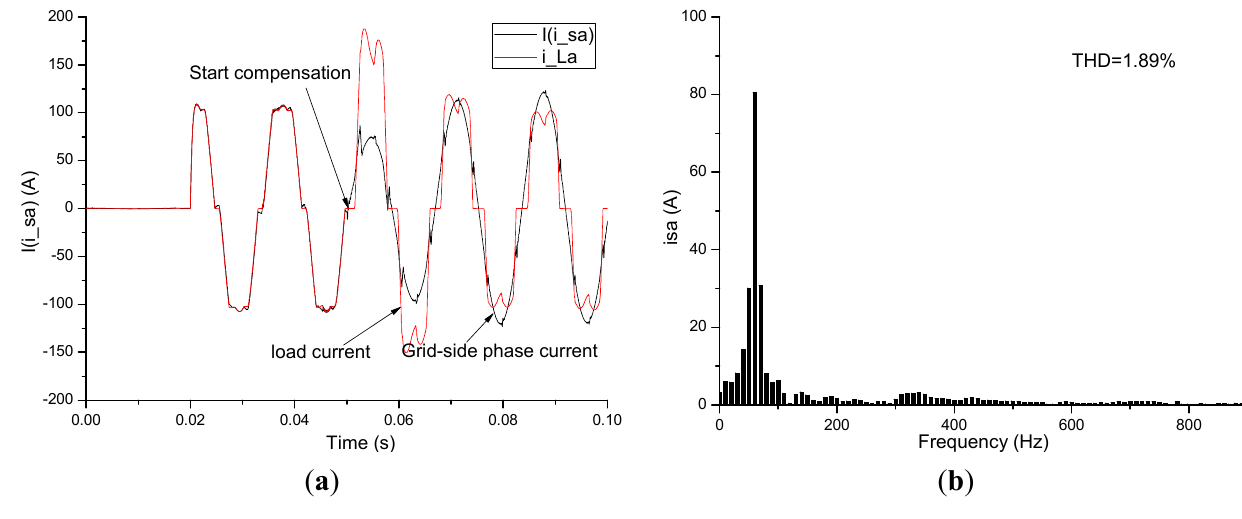
Figure 7. Time response and spectrum of the grid-side phase current before and after integration of the non-linear load: ( a ) load current; and ( b ) spectrum of the load current.